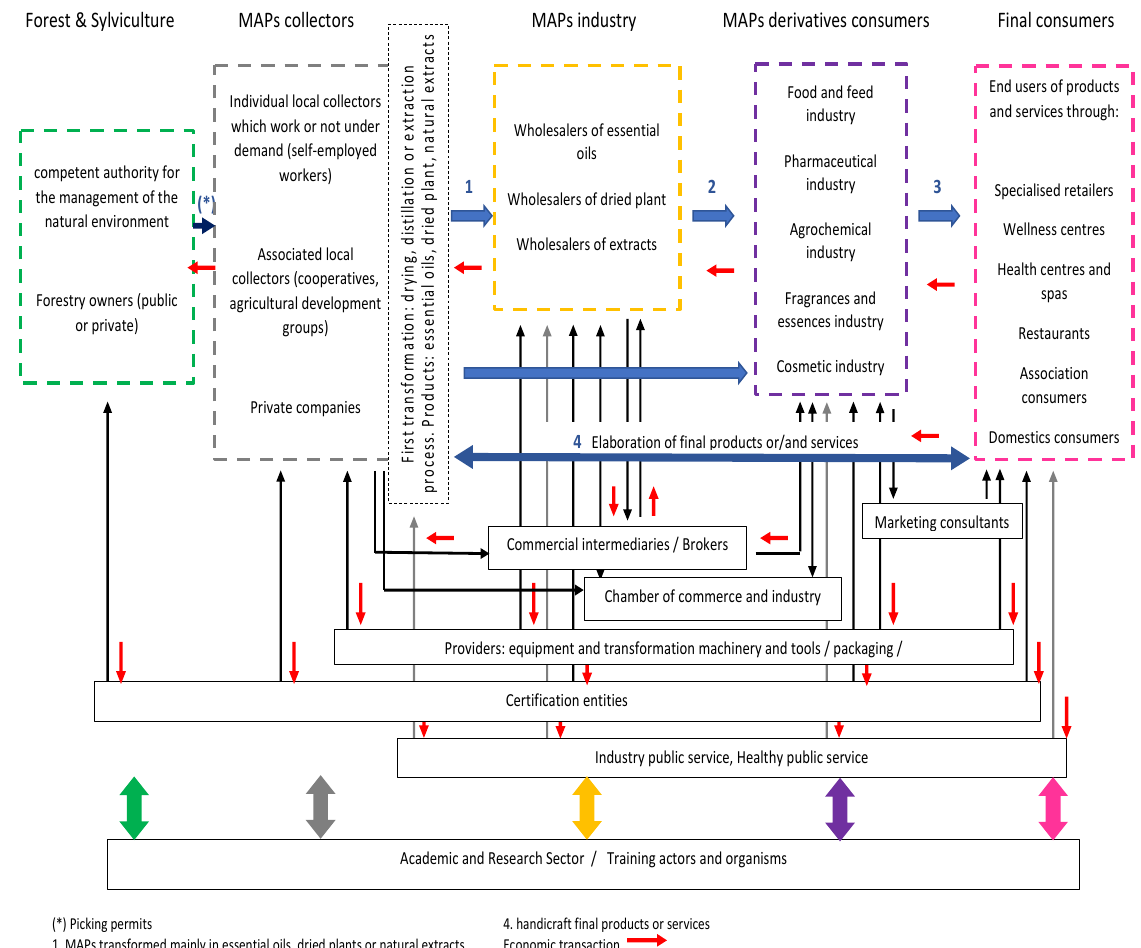
Figure 1. Description of the MAP supply chain developed during the INCREDIBLE events and validated by the MAP panel of experts by means of the Delphi survey methodology.